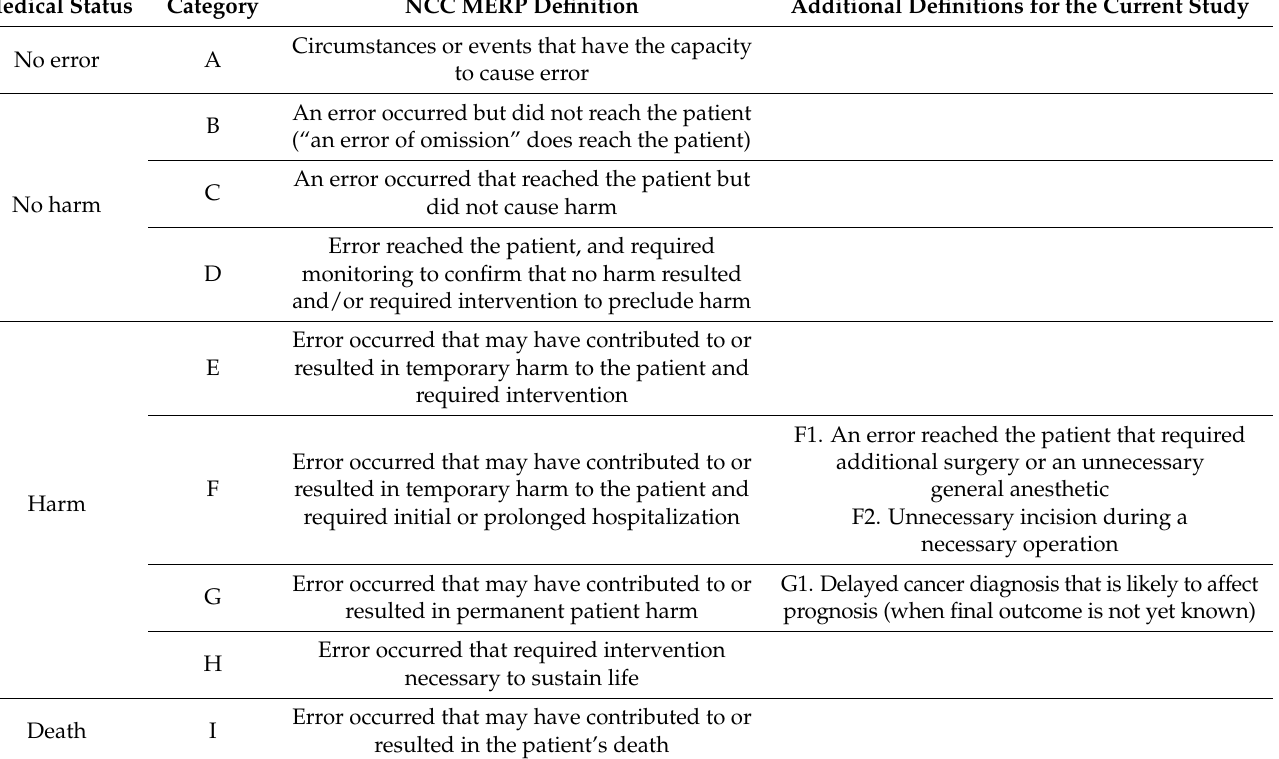
Table 1. The definition of levels of harm. National Coordinating Council for Medication Error Reporting and Prevention Index for categorizing of medication errors, with added definitions for the current study [58]. Abbreviations used: NCC MERP, National Coordinating Council for Medication Error Reporting and Prevention. Reprinted with permission from Ref. [58]. 2004 Wiley Online